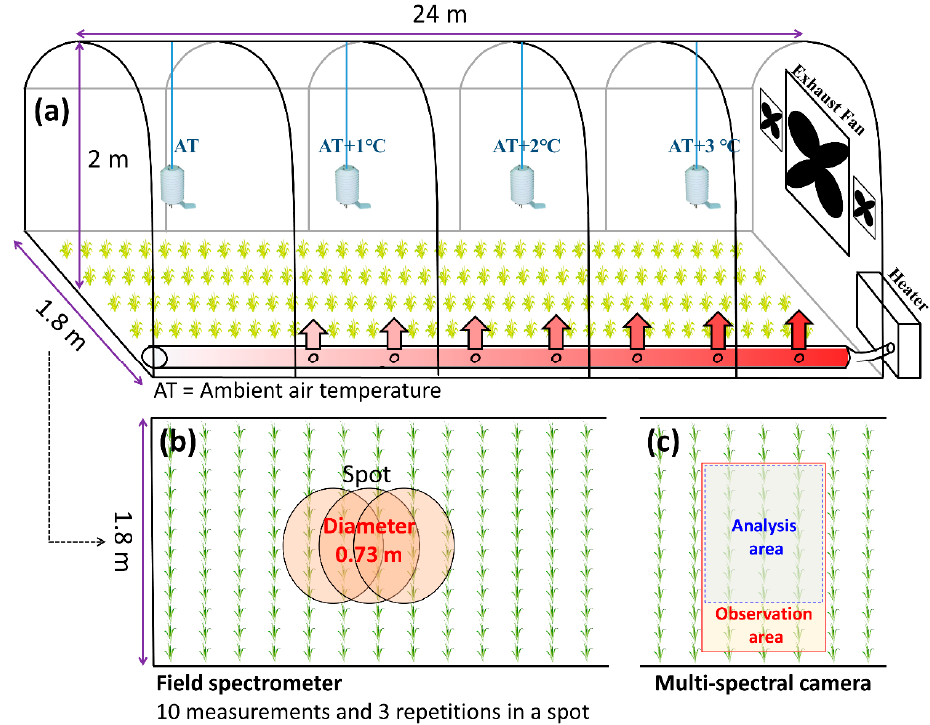
Figure 1. Temperature gradient field chamber (TGFC) diagram. ( a ) Structural characteristics of the TGFC. Observation methods of ( b ) field-spectrometer and ( c ) multi-spectral camera. Paddy rice was cultivated in the TGFCs and the outside paddy field for four